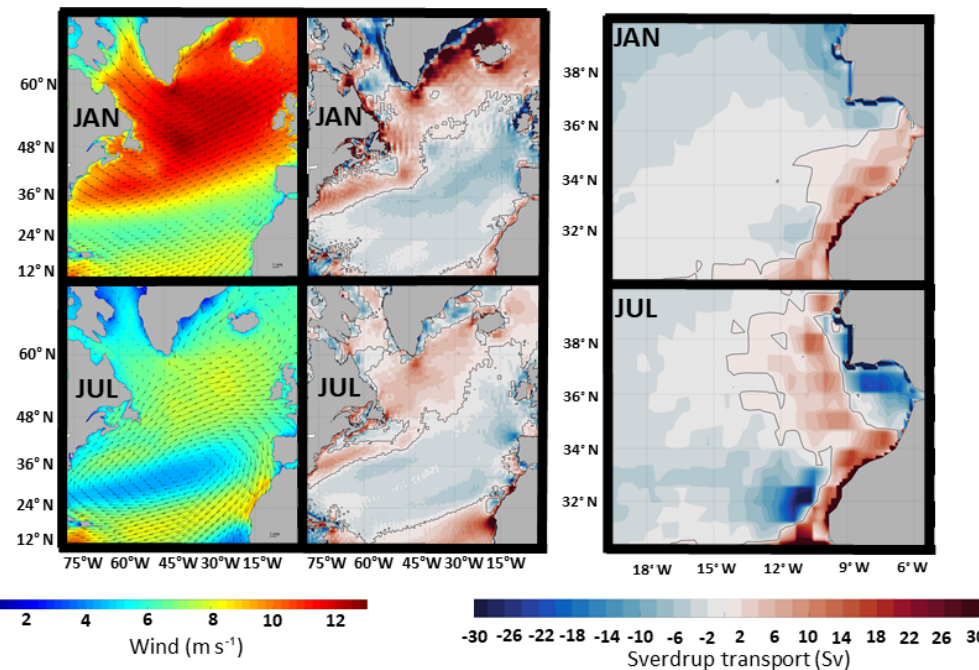
Figure 11. Maps of surface winds and Sverdrup transport in January (top) and July (bottom). Right maps are a zoomed study region of surface Sverdrup transport.